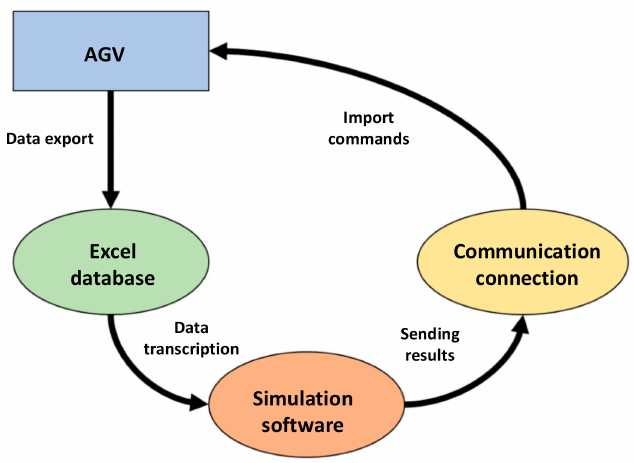
Figure 7. The principle of the communication interface in AGV—Simulation